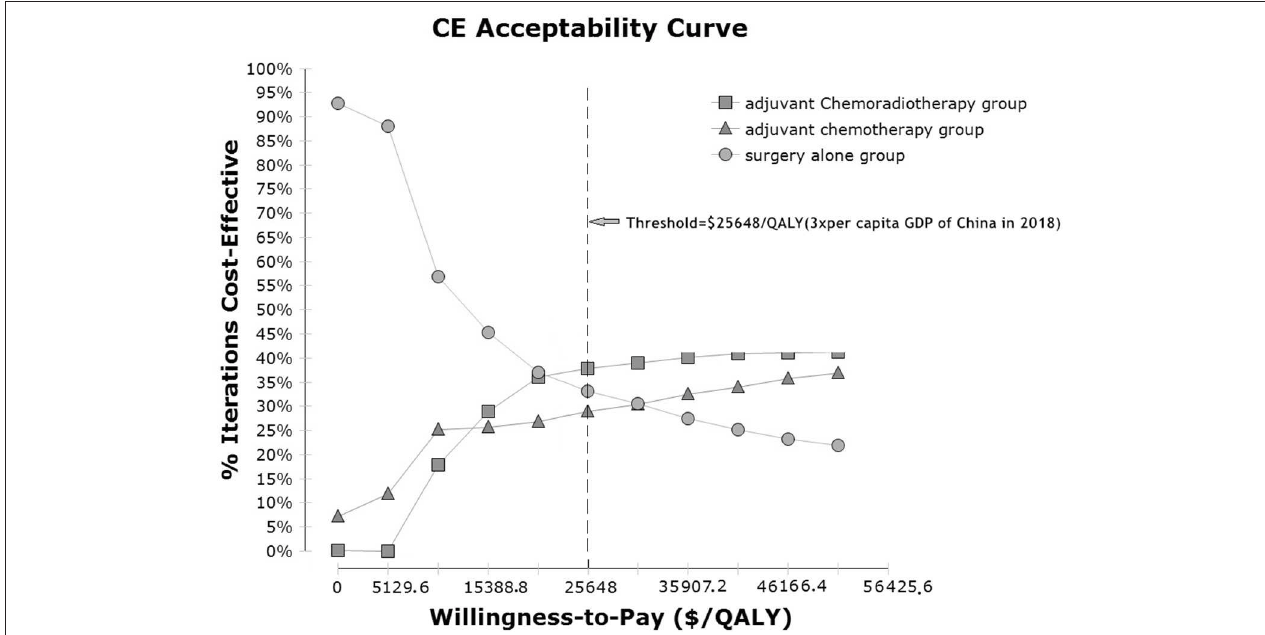
FIGURE 3 | Cost-effectiveness acceptability curves for the three adjuvant strategies in localized gastric cancer after D2-gastrectomy. Cost-effectiveness probabilistic acceptability curves showing the probabilities of acceptability of each strategy for different WTP thresholds. The horizontal axes represent willingness-to-pay thresholds to gain 1 additional QALM. Three curves are presented for the adjuvant chemotherapy group, adjuvant chemoradiotherapy group, and observation group. CE, cost-effectiveness; QALM, Baseline demographic and clinical characteristics quality-adjusted life month; GDP: gross domestic